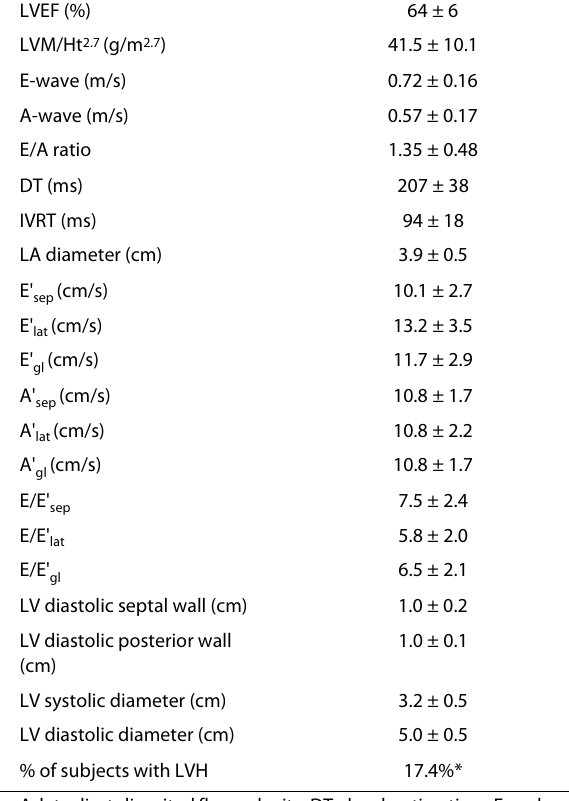
Table 2: Echocardiographic measurements of study population (n =